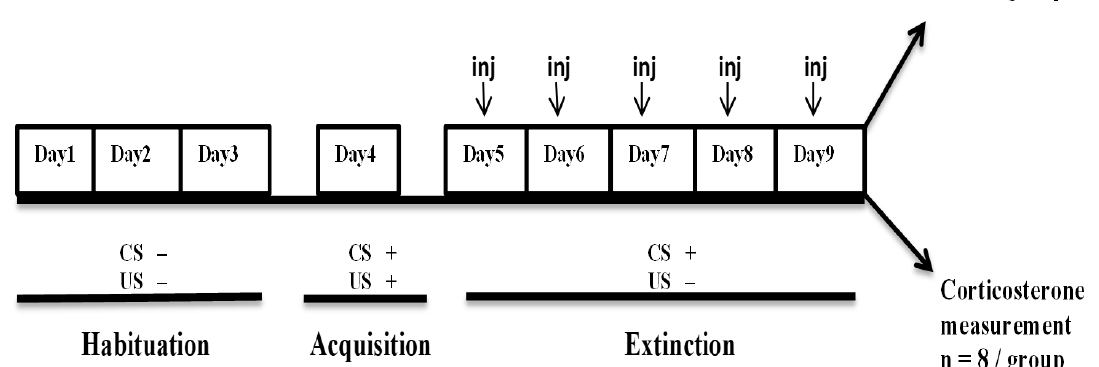
Figure 6. Experimental design for behavioral study.